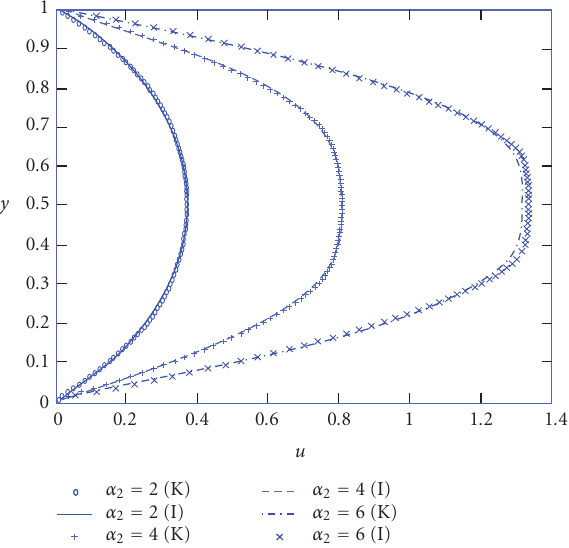
Figure 4.1. Velocity profiles for various values of α 2 and fixed α 1 = 1 (I: Wang et al. solution; K: our solution) for dp/dx = − 2.